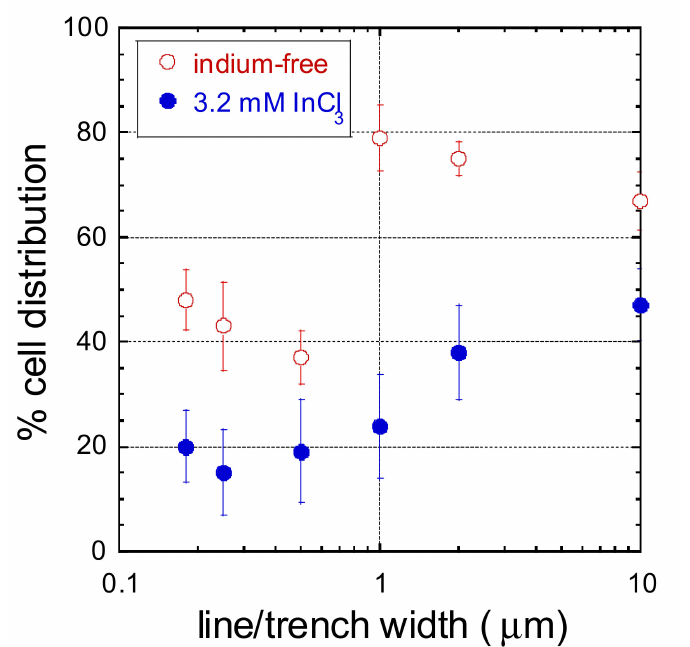
Figure 8. Percent cell distribution of cells aligned within ± 10 ◦ of line axes as a function of line